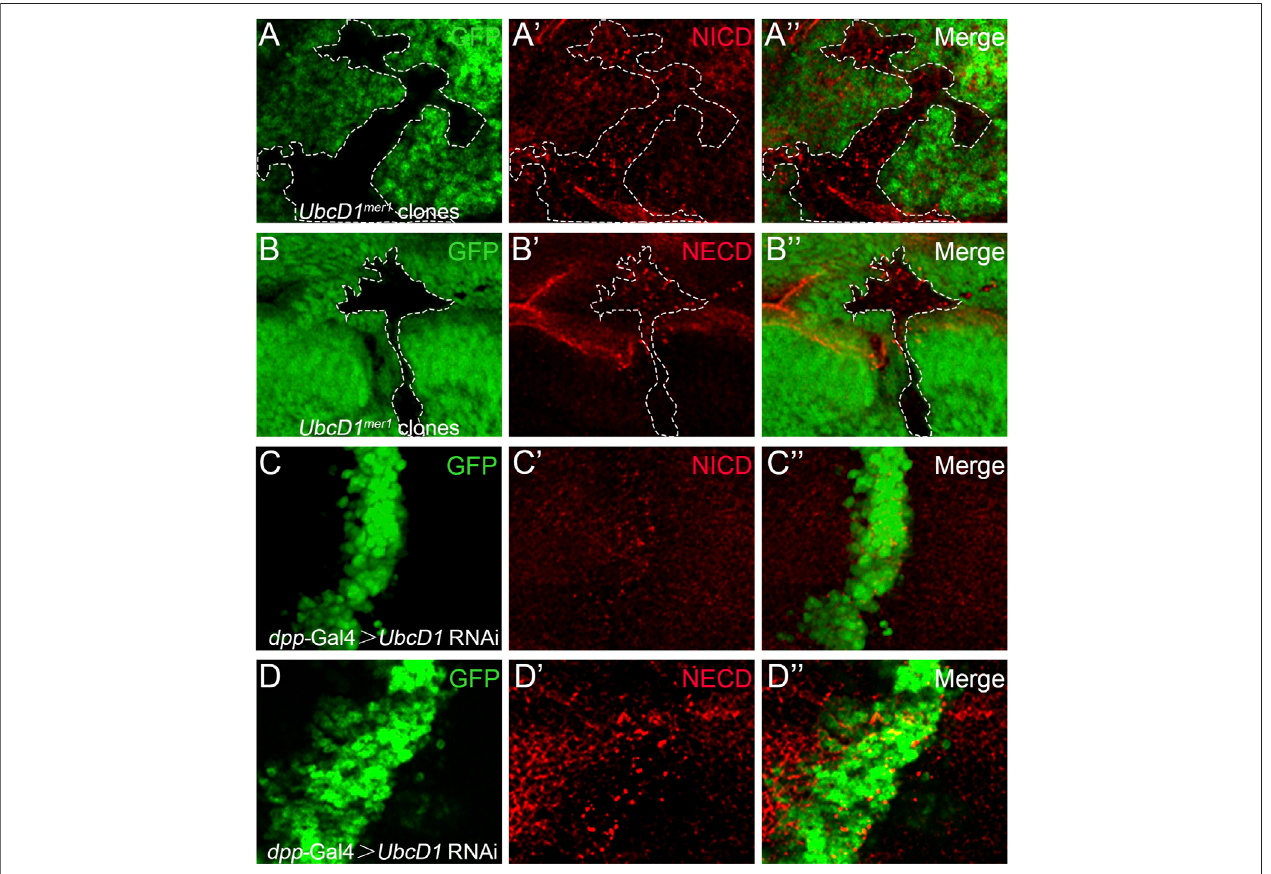
Figure 3D: C5-Gal4, UAS-GFP × UbcD1 RNAi. Figure 3E: C96-Gal4, UAS-GFP . Figure 3F: C96-Gal4, UAS-GFP × UbcD1 RNAi. Figure 4A: hsFlp; Tub-Gal4, UAS-GFP; FRT82B, Tub-Gal80 × FRT82B, UbcD1 mer1 . Figure 4B: hsFlp; Tub-Gal4, UAS-GFP; FRT82B, Tub-Gal80 × UAS-Dl; FRT82B . Figure 4C: hsFlp; Tub-Gal4, UAS-GFP; FRT82B, Tub-Gal80 × UAS-Dl; FRT82B, UbcD1 mer1 . Figure 4D: hsFlp; Tub-Gal4, UAS-GFP; FRT82B, Tub-Gal80 × UAS-N FL ; FRT82B, UbcD1 mer1 . Figure 4E: hsFlp; Tub-Gal4, UAS-GFP; FRT82B, Tub-Gal80 × UAS-NICD; FRT82B, UbcD1 mer1 . Figure 5A, B: FRT82B, UbcD1 mer1 × Ubx-Flp; FRT82B, Ubi-GFP . Figure 5C, D: dpp-Gal4, UAS-mCD8-GFP × UbcD1 RNAi. Figure 6A, B: FRT82B, UbcD1 mer1 × Ubx-Flp; FRT82B, Ubi-GFP . Figure 6C: dpp-Gal4, UAS-mCD8-GFP × UbcD1 RNAi.